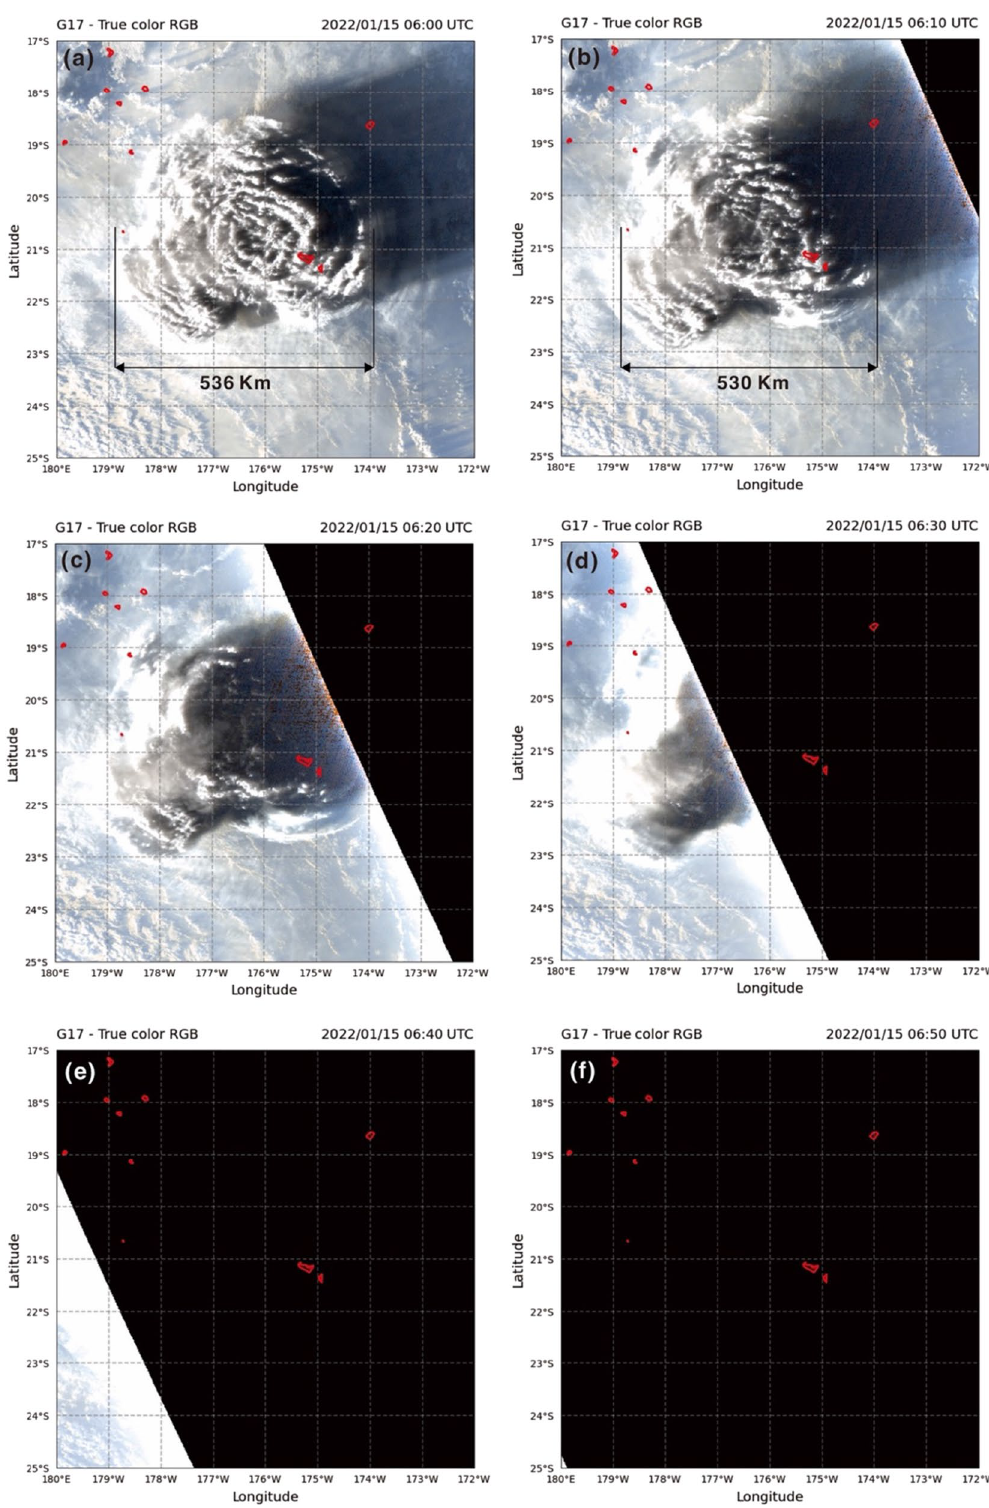
Fig. 11 True color RGB using GOES-17 from 06:00 to 06:50 on 15 January 2022. ( a ) 2020/01/15 06:00 UTC, ( b ) 2020/01/15 06:10 UTC, ( c ) 2020/01/15 06:20 UTC, ( d ) 2020/01/15 06:30 UTC, ( e ) 2020/01/15 06:40 UTC, ( f ) 2020/01/15 06:50